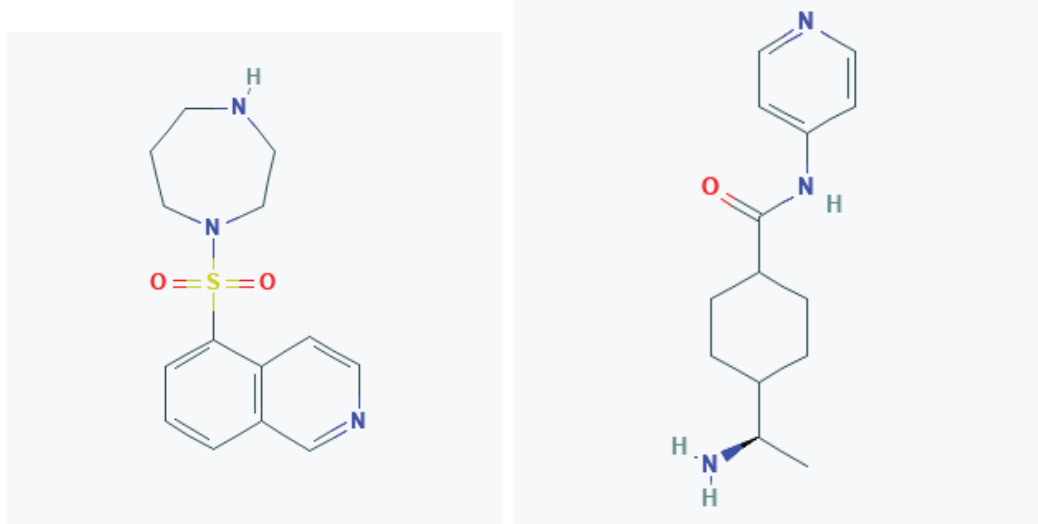
Figure 2. Pharmacological ROCK inhibitors Fasudil and Y-27632.Chemical structures of two widely used ROCK inhibitors, Fasudil and Y-27632. Both ROCK inhibitors have been demonstrated to alleviate functional deficits in mouse models of TBI. Images were taken from the National Center for Biotechnology Information, PubChem Database; Fasudil: https: // pubchem.ncbi.nlm.nih.gov / compound / Fasudil; Y-27632: https: // pubchem.ncbi.nlm.nih.gov / compound /